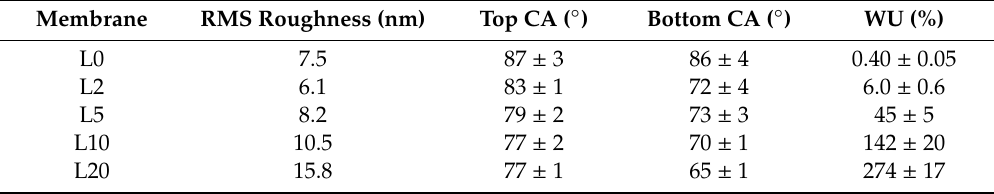
Table 2. RMS roughness of bottom side, water contact angle (CA) and Water Uptake (WU) of PSf-mG20